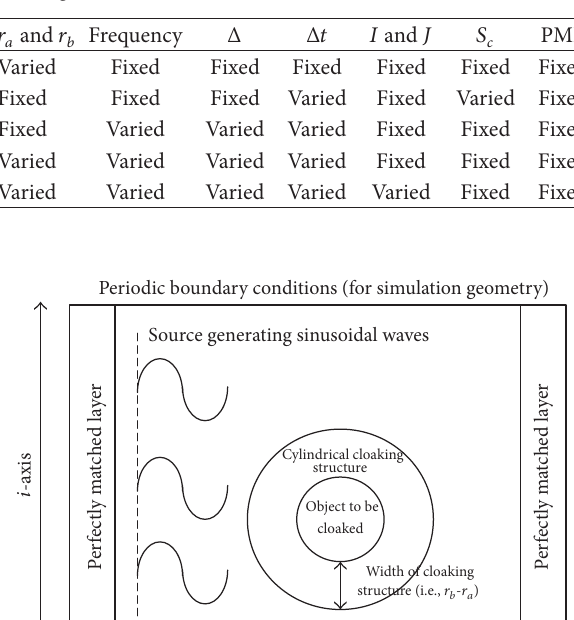
Table 1: Parametric variations considered for the study of the FDTD cloaking model.